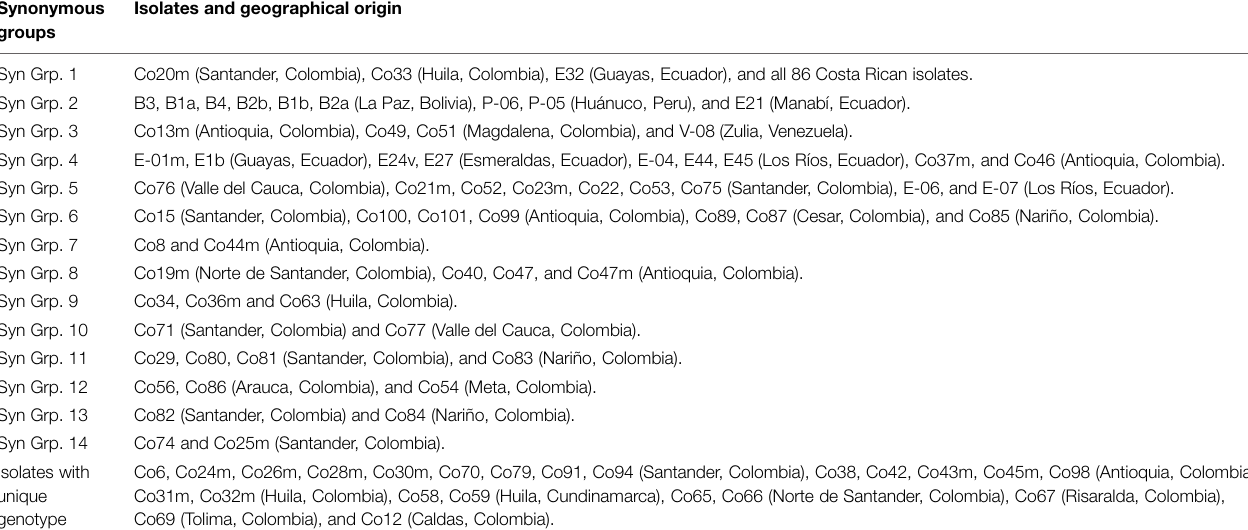
TABLE 2 | Geographic origin of 172 Moniliophthora roreri isolate.